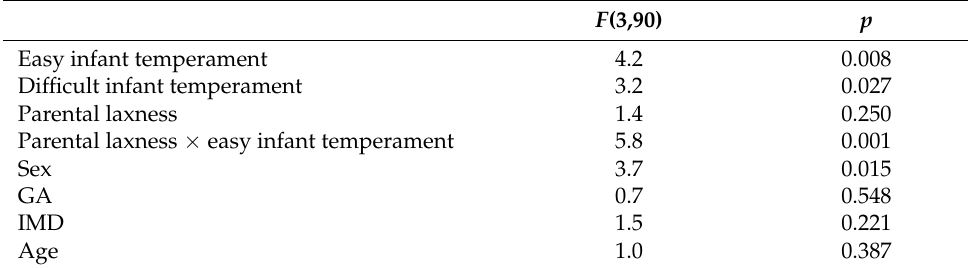
Table 4. Results of the winning multivariate regression analysis jointly regressing childhood temper- ament (Negative Affect, Surgency and Effortful Control) on easy and difficult infant temperament, parental laxness and its interaction with easy infant temperament, controlling for age, sex, gestational age (GA) and index of multiple deprivation (IMD). A Bonferroni-corrected significance threshold of p = 0.008 was used.